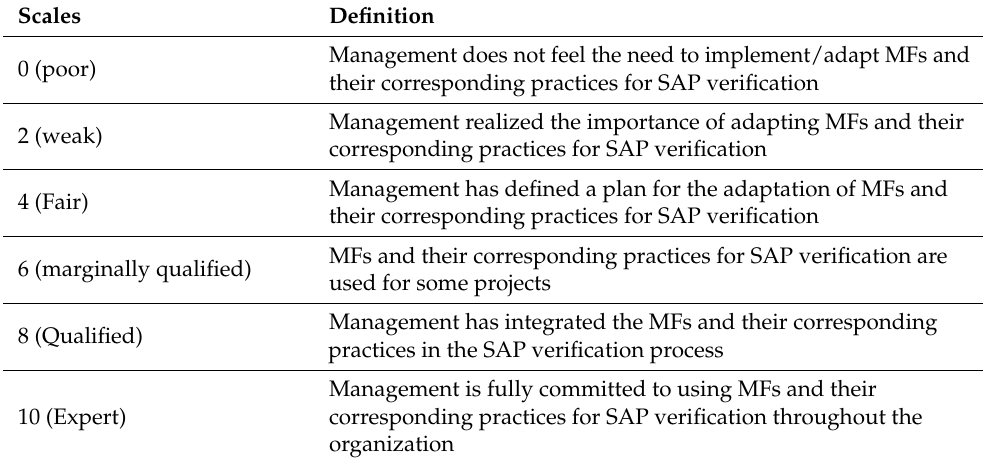
Table 4. Definition of evaluation